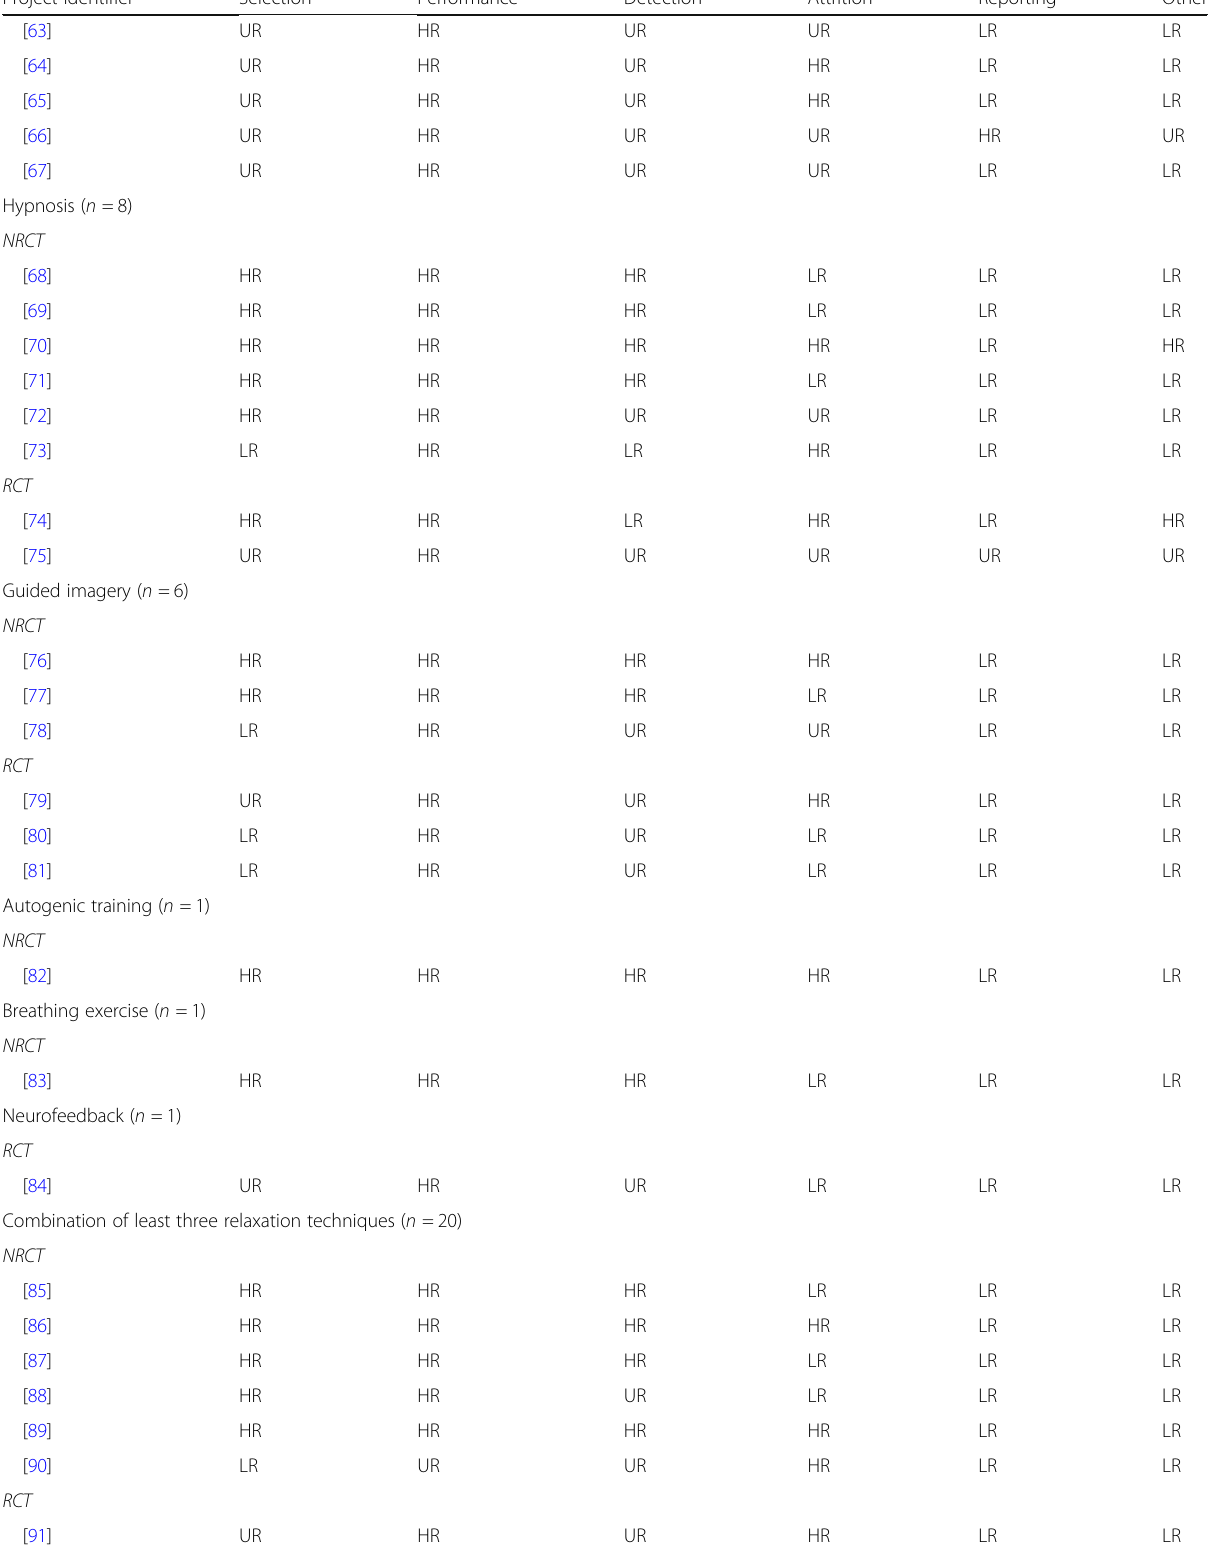
Table 3 Risk of bias of included studies (Quantitative approaches)